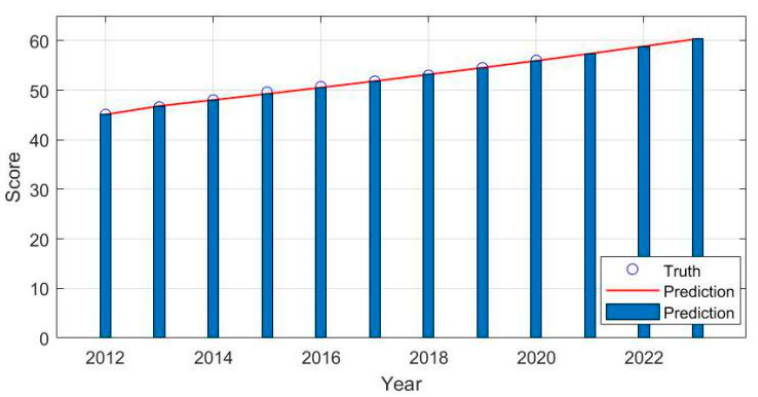
Figure 15. Predication of sector’ digital transformation in China.